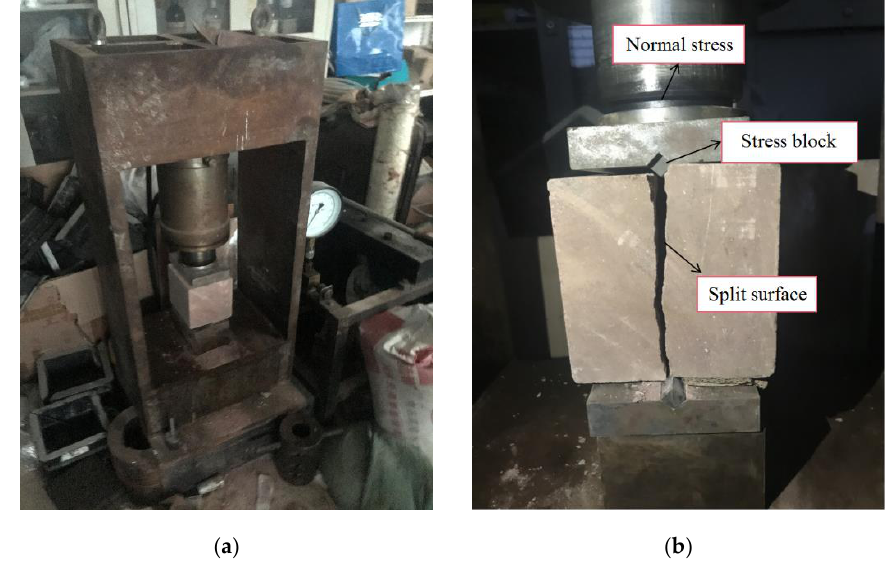
Figure 2. Normal shear rock fracture: ( a ) the normal splitting test and ( b ) split fracture.